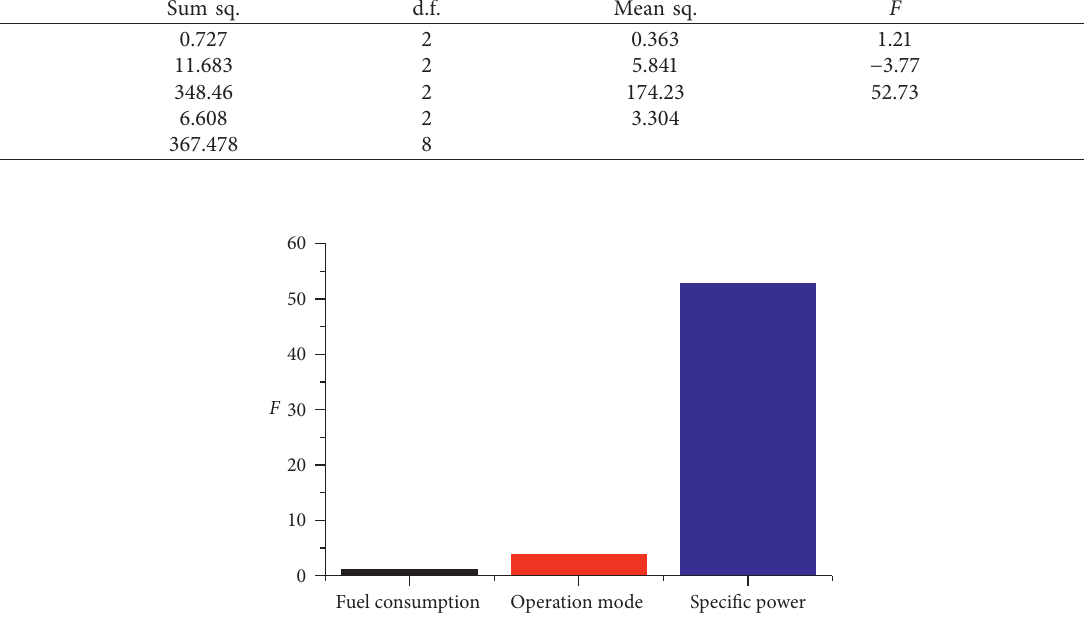
Figure 9: The influence factor F